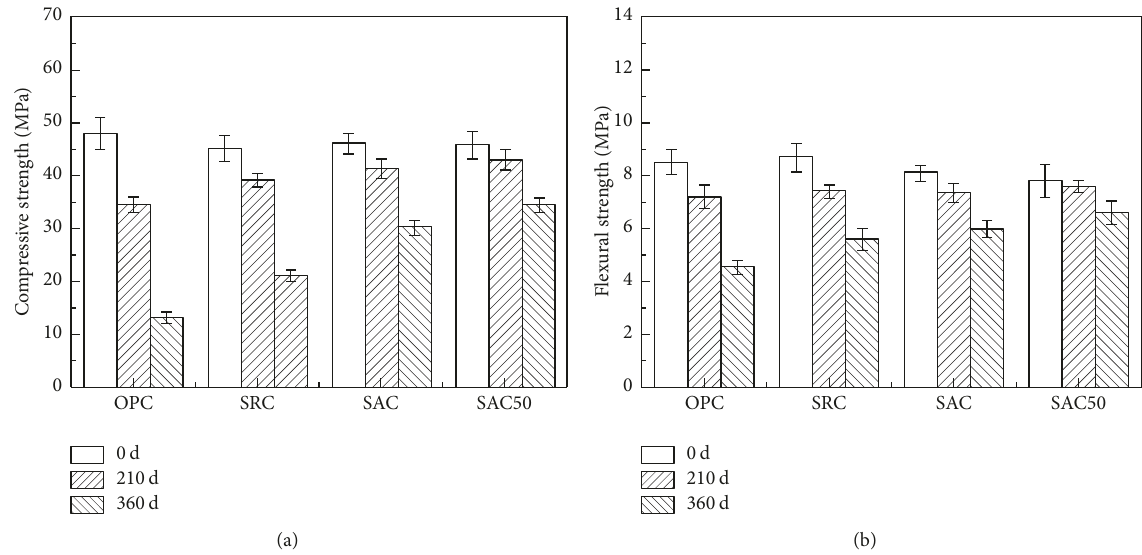
Figure 2: Strength development of mortars with different types of cement with immersion time: (a) compressive strength, (b) flexural